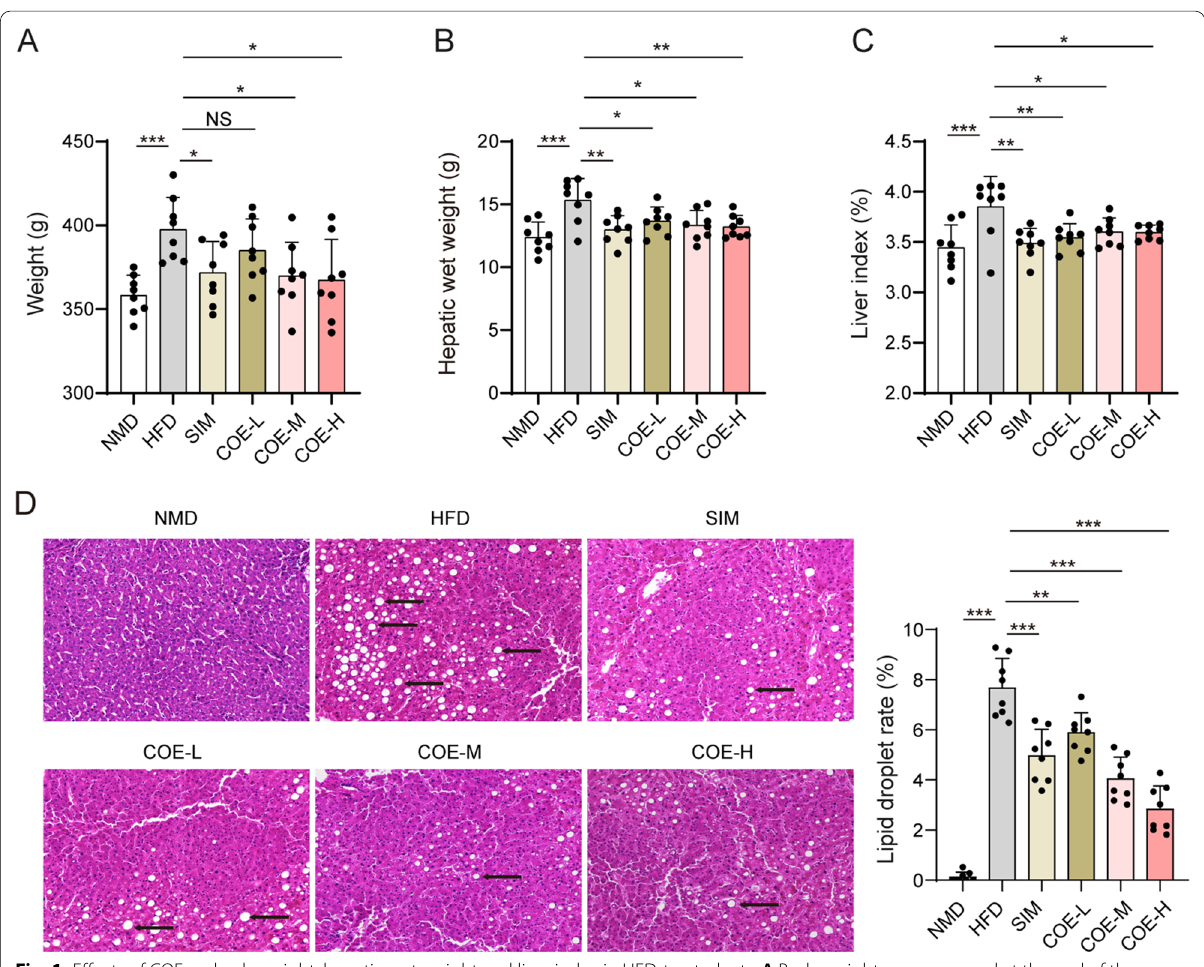
Fig. 1 Effects of COE on body weight, hepatic wet weight and liver index in HFD-treated rats. A Body weight was measured at the end of the experimental period. B Hepatic wet weight was determined after COE or SIM treatment. C The liver index was assessed after COE or SIM treatment. D Histopathological changes in the liver of rats observed by H&E staining (black arrow indicated fat vacuole infiltration). NMD, normal diet. HFD, high-fat diet. SIM, simvastatin. COE, ethanol extract of Chimonanthus nitens Oliv. leaf. COE-L, COE at the low dose, COE-M, COE at the medium dose. COE-H, COE at the high dose. n 8; * P < 0.05, ** P < 0.01, *** P < 0.001 vs . NMD or HFD =